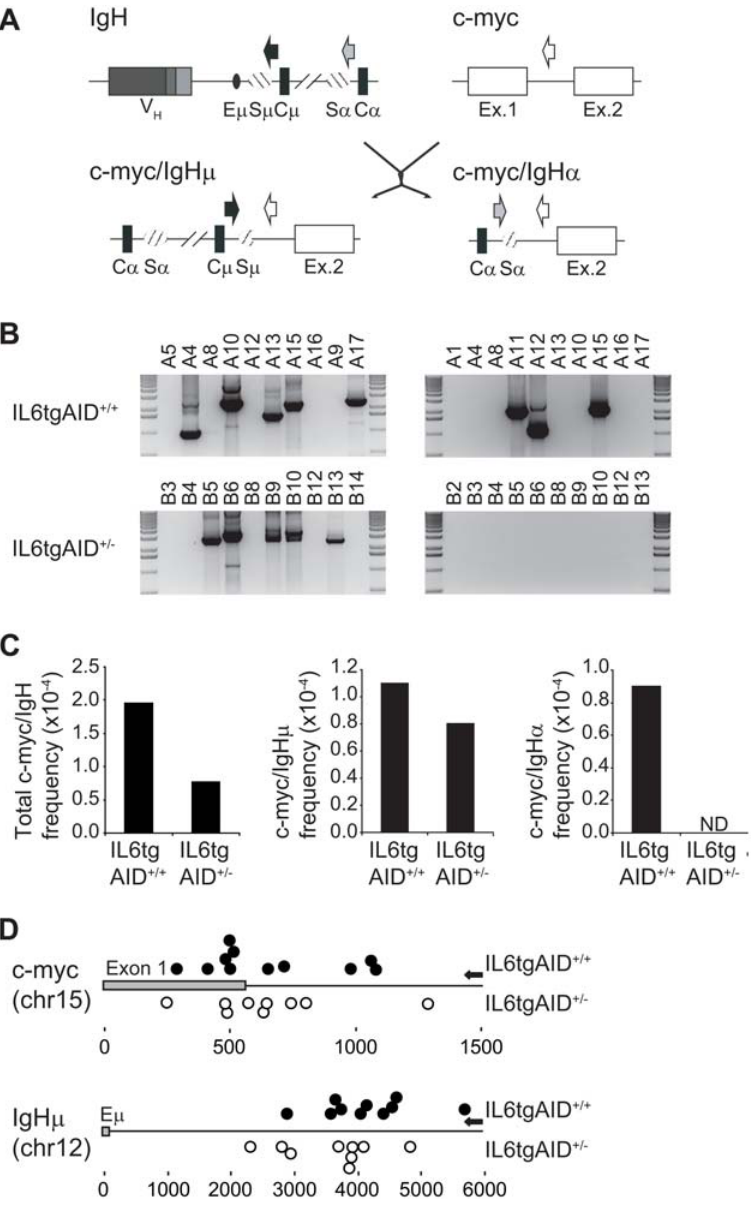
Figure 3. c-myc/IgH translocation frequency is reduced in IL6tgAID + / 2 mice. (A) Schematic representation of the IgH and c-myc genes (upper) and the derivative chromosomes (c-myc/IgH m and c-myc/IgH a , lower) arising from proximal and distal translocations, respectively. Variable (V H ) and constant (C m and C a ) genes are represented as grey and black boxes, respectively. S m and S a switch regions and E m enhancer are shown as striped and black ellipses, respectively. C-myc exons are drawn as white boxes. Arrows show the position of primers used for PCR amplification. (B) Proximal (left) and distal (right) c-myc/IgH translocations detected in IL6tgAID + / + (upper gels) and IL6tgAID + / 2 (lower gels) mice. DNA from IL6tgAID + / + and IL6tgAID + / 2 hyperplastic lymph node B cells was amplified as described in materials and methods using the primers depicted in (A). Representative amplification products analysed in ethidium bromide stained gels are shown. Mouse identifications are shown above the lanes. (C) Frequency of c-myc/ IgH translocations in IL6tgAID + / + and IL6tgAID + / 2 mice. Translocation frequency was determined by serial dilution of DNA samples, followed by PCR amplification, cloning and sequencing. Graphs show the overall translocation frequency (left), frequency of proximal c-myc/IgH m translocations (middle) and frequency of distal c-myc/IgH a translocations (right). (D) Representation of translocation breakpoints at the c-myc and IgH m genes found in IL6tgAID + / + and IL6tgAID + / 2 B cells. Amplification products of proximal c-myc/IgH translocations were cloned and sequenced. Translocation breakpoints at the c-myc (upper diagram) and IgH (lower diagram) genes are shown as closed (IL6tgAID + / + ) and open (IL6tgAID + / 2 ) circles. C-myc exon 1 and IgH E m enhancer are represented as grey boxes and distance to these elements is shown underneath (bps). Arrows on the right indicate the position of the PCR oligonucleotides used for